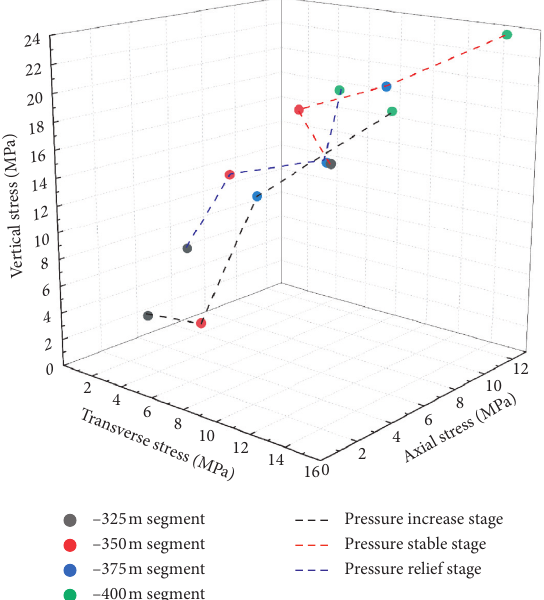
Figure 7: Time-space evolution process of three-dimensional stress peak.